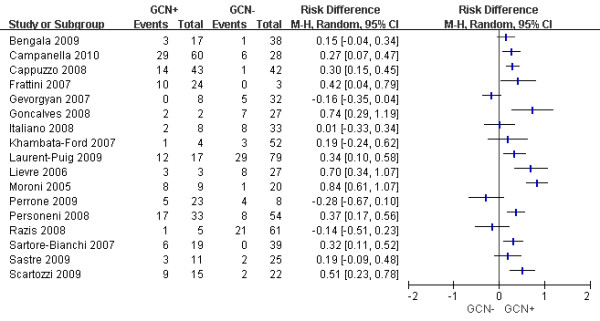
Difference in objective response rate between GCN + and GCN- patients. For GCN + group, the total events and patients were 125 and 301, respectively. For GCN- group, the total events and patients were 106 and 590, respectively. Heterogeneity test: P <0.00001, I2 = 78%.